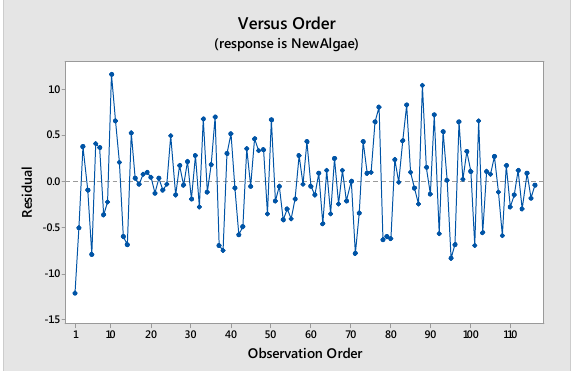
Figure 5. Residuals versus observation order.